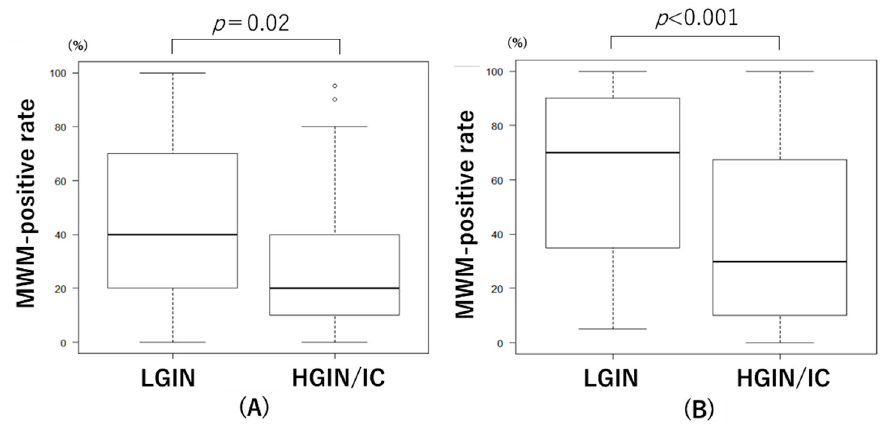
Figure 4. Relationship between histological tumor grades and endoscopic milk-white mucosa (MWM)-positive rates in resected specimens ( A ) and those in preoperative endoscopy ( B ). LGIN, low-grade intraepithelial neoplasia; HGIN, high-grade intraepithelial neoplasia; IC, intramucosal carcinoma.